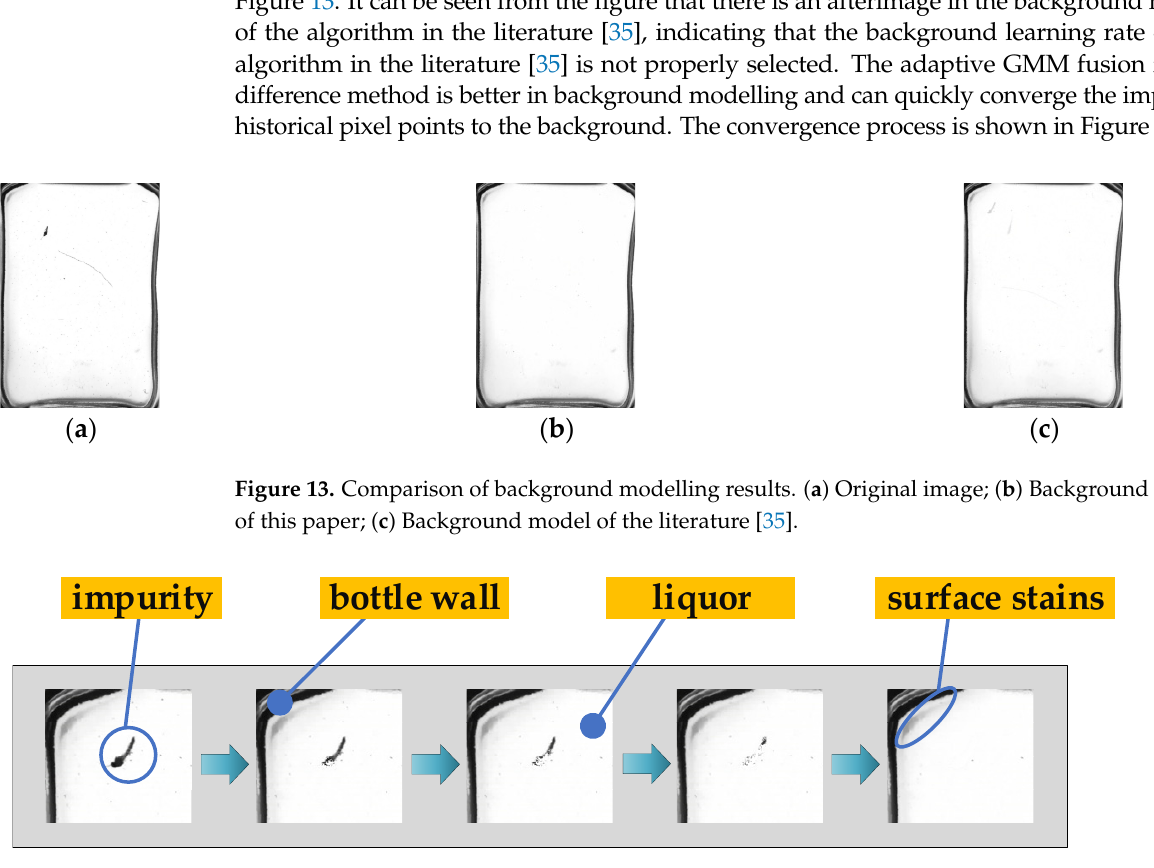
Figure 12. Calibration of the impurity detection area for bottled Baijiu.